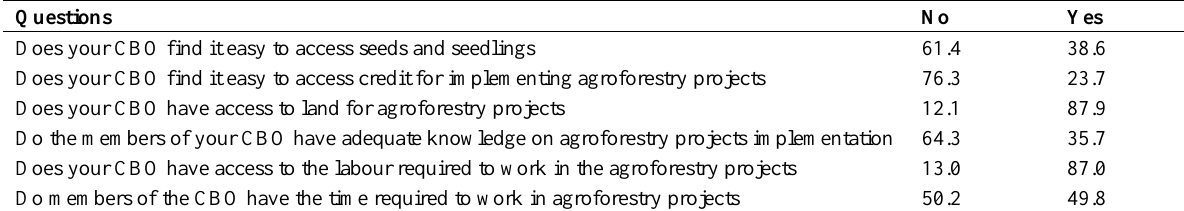
Table 2: Respondents views on Challenges faced by CBOs in Agroforestry